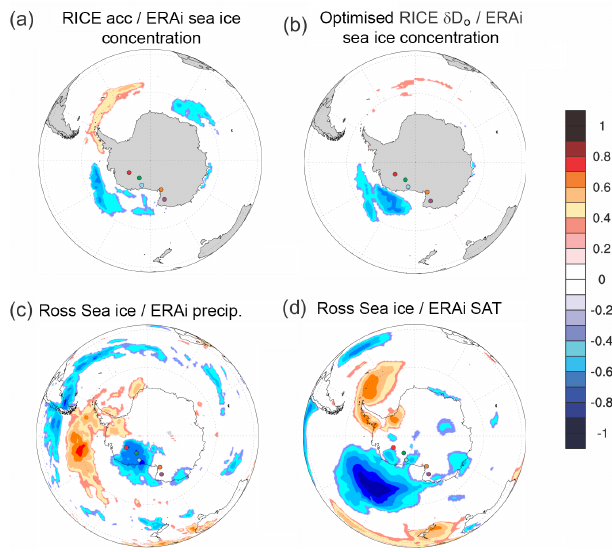
Figure 5. Panels (a) and (b) : spatial correlation of ERAi sea ice concentration (SIC) fields with the time series of (a) RICE snow ac- cumulation and (b) RICE δ D o . Panels (c) and (d) : spatial correlation of the Ross–Amundsen Sea SIE J time series (Jones et al., 2016) with (c) ERAi precipitation and (d) ERAi SAT fields. Only fields exceeding ≥ 95% significance are shown. The correlation has been performed using http://climatereanalyzer.org/, University of Maine, USA. Coloured dots indicate locations of WDC (red), Siple Dome (green), RICE (blue), TALDICE and Talos Dome (purple) and Tay- lor Dome